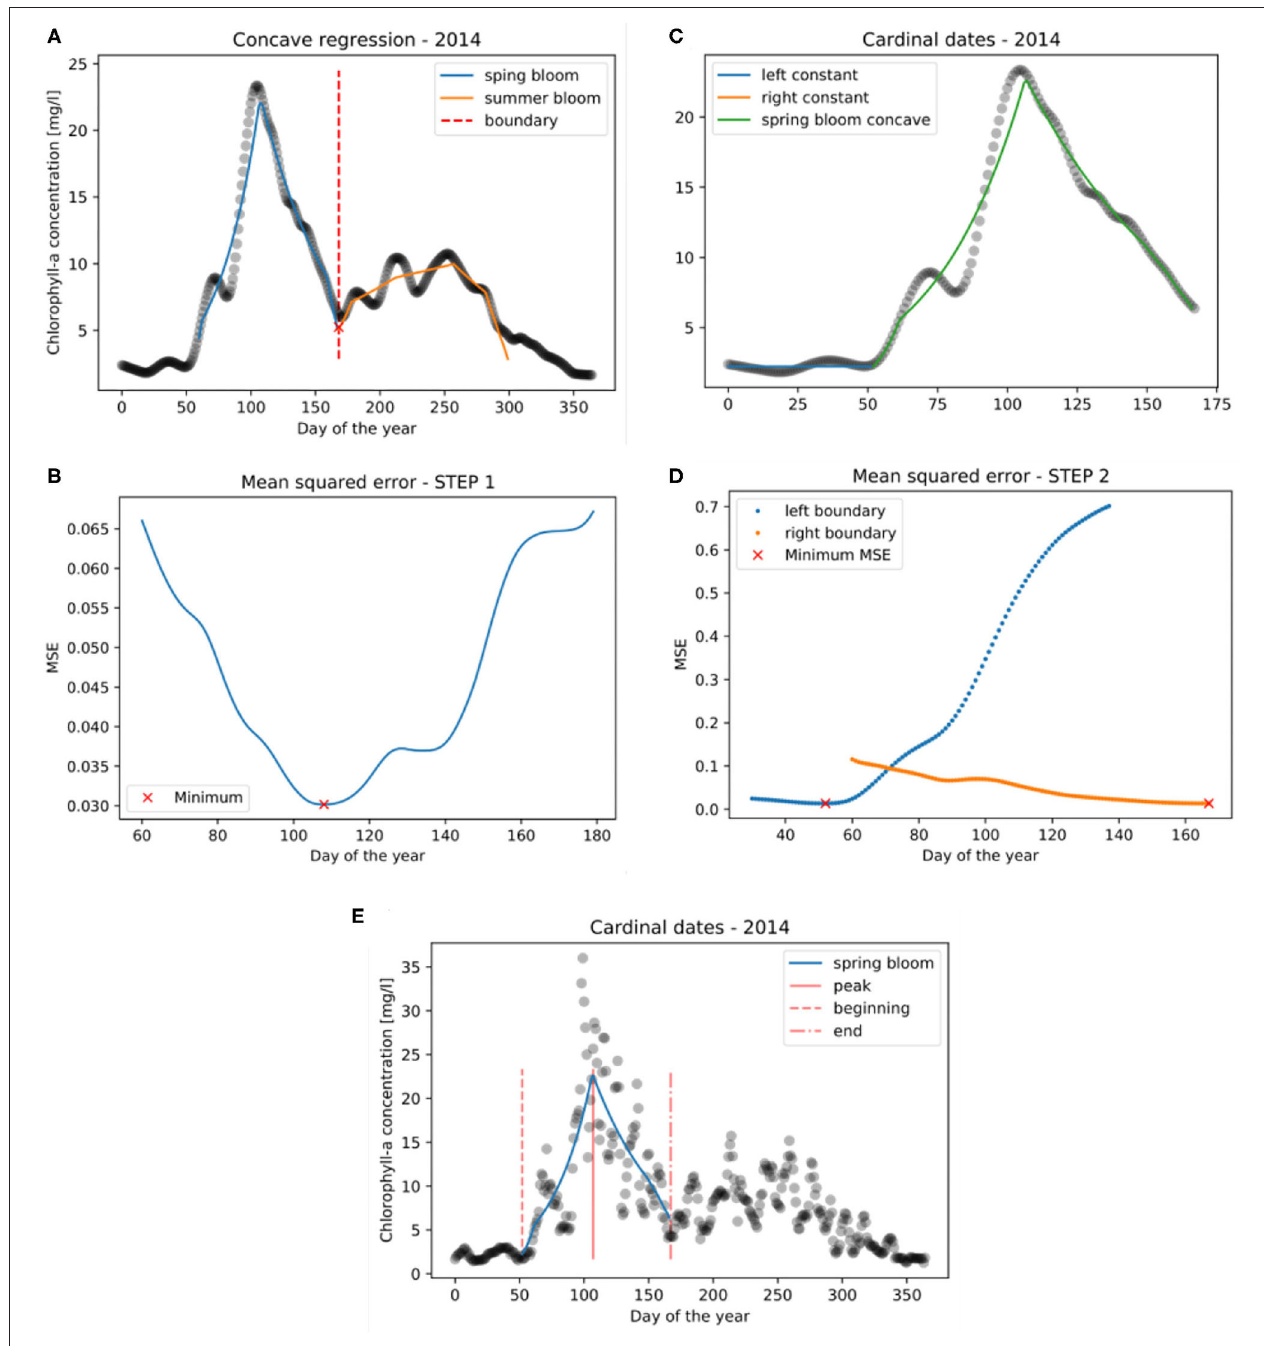
FIGURE 7 | Steps to derive the cardinal dates of phytoplankton spring blooms: (1) Determining the boundary ( t b ) for isolating the spring bloom (A,B) , and (2) concave regression to spring bloom (C,D) . The cardinal dates of the spring bloom are shown in (E)